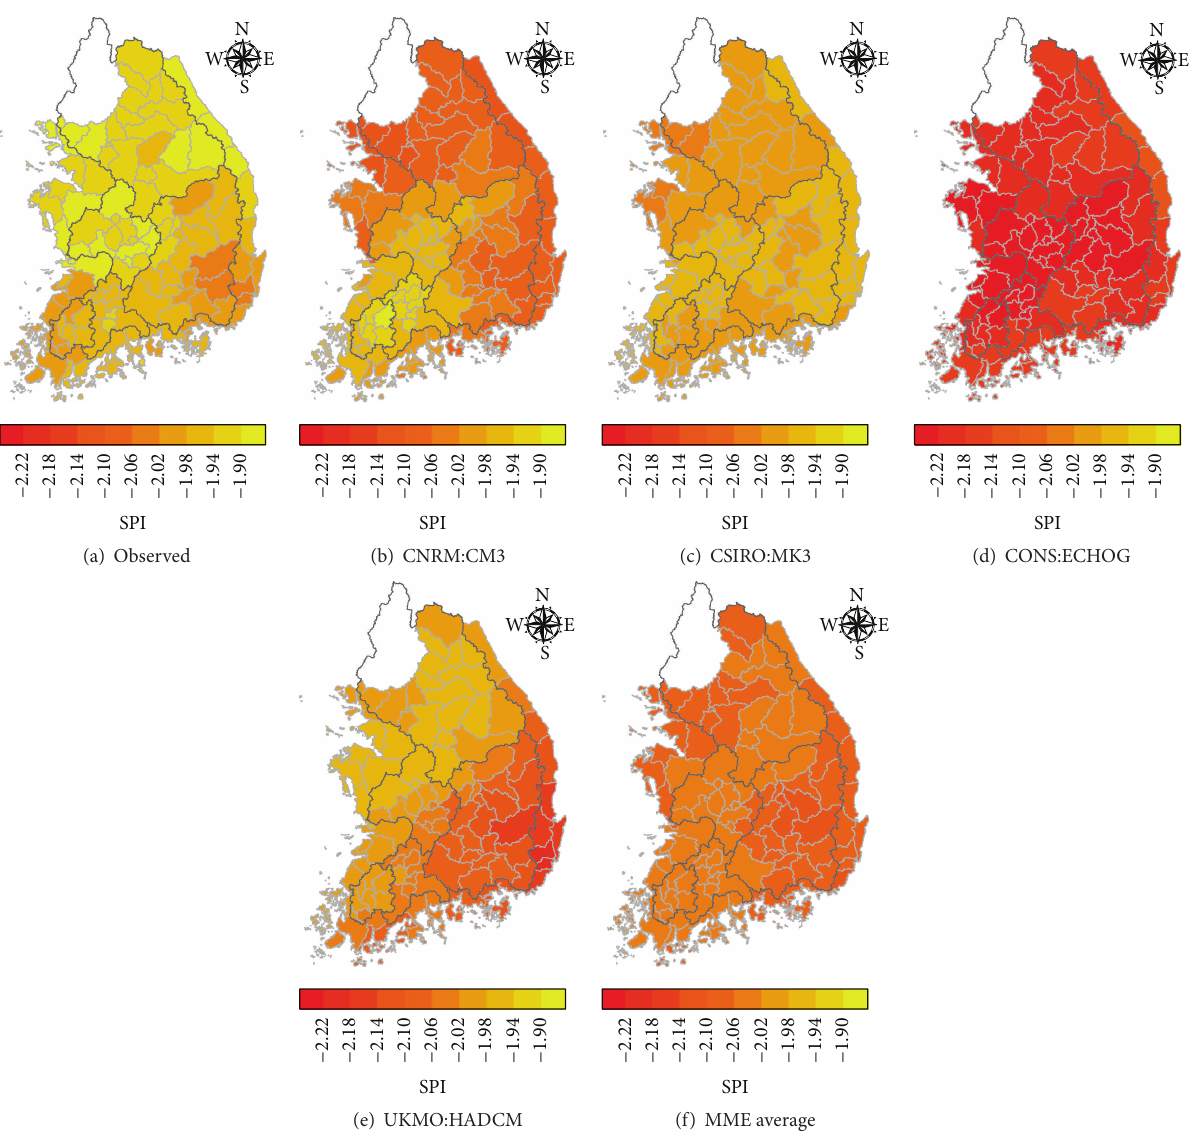
Figure 8: The spatial distribution of the severity of drought with three-month SPI less than or equal to − 1.5 for past and future climate change projections. (a) Observed severity of drought for the period 1976–2010 and (b–f) projected severity of drought by each GCM and MME average for the period 2011–2099 for the climate change scenario. Note that the SPI series is calculated from a downscaled monthly precipitation using the four GCMs as